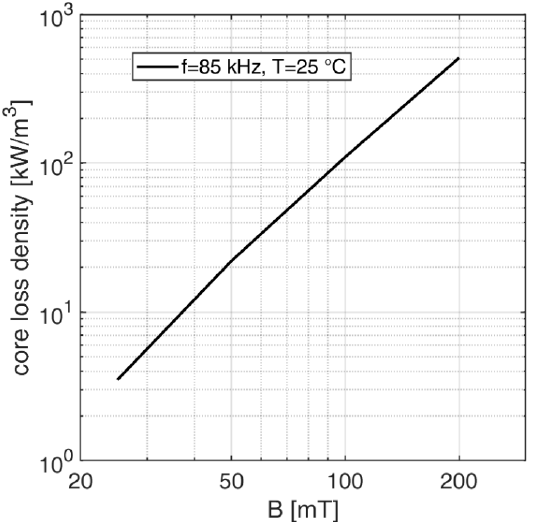
Figure 7. Losses in the ferrite core vs. AC magnetic flux density at 85 kHz and 25 °C. This curve is obtained by interpolation of the manufacturer data sheets reported in [35].